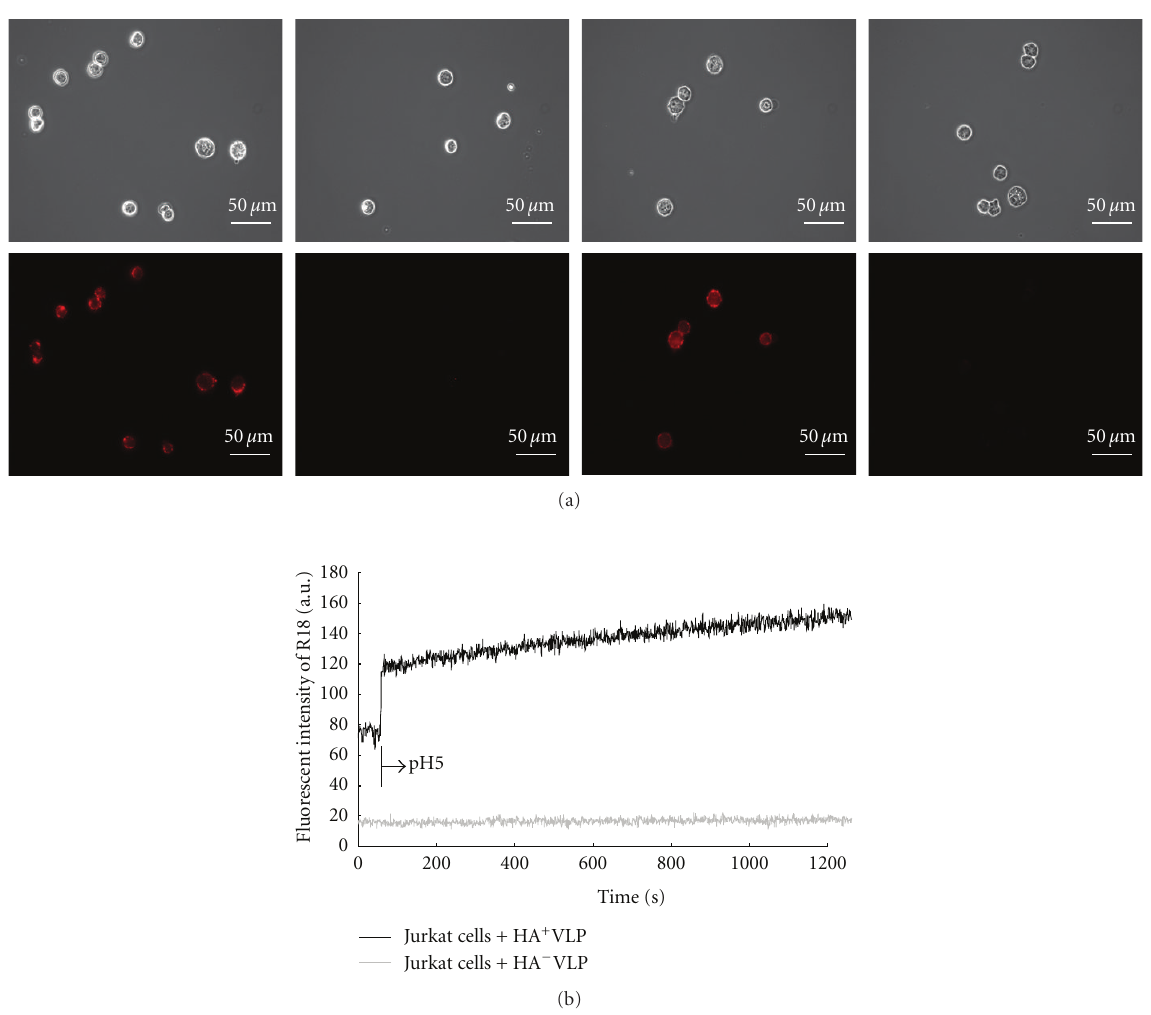
Figure 5: Membrane fusion of VLPs with Jurkat cells. Jurkat cells were mixed with R18-labeled VLPs for 10 min and then collected for detection of the membrane fusion. The fusion process was initiated by lowering the external pH to 5. (a) shows HA + VLP binding, HA − VLP binding, HA + VLP bound to cells at pH5 for 2min, HA − VLP bound to cells at pH5 for 2min, from left to right. Graph in (b) depicts the time profile of VLP fusion with plasma membrane triggered by acidification at 1min as indicated. The autofluorescence of Jurkat cells obtained as a control was subtracted from the intensity